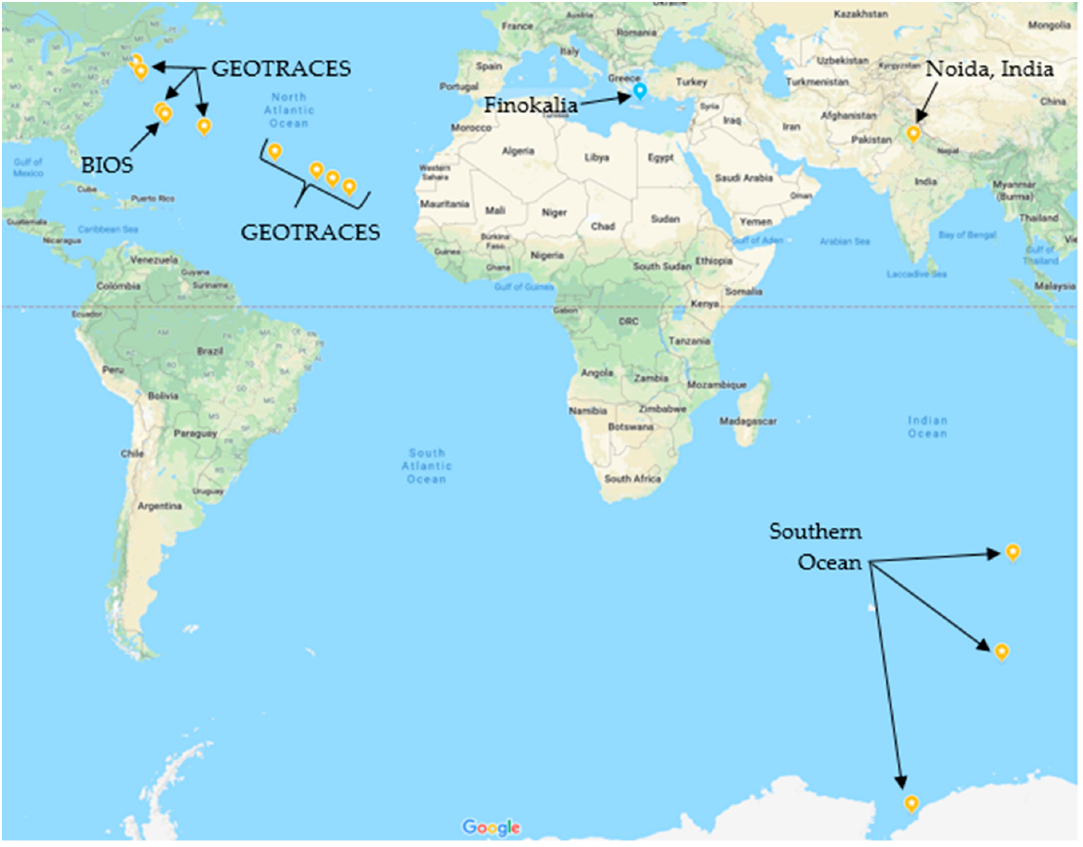
Figure 1. Global map with sampling locations indicated. Precise latitude and longitude for each sampling location can be found in Table S3.